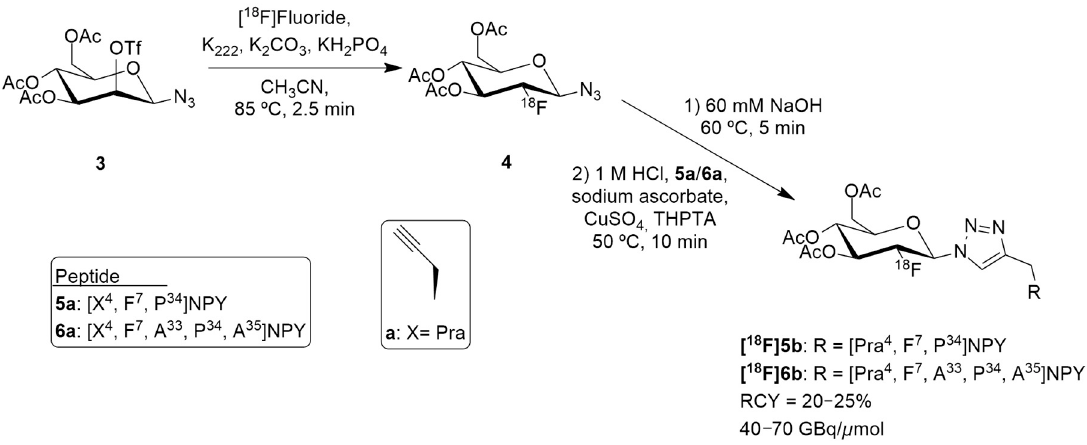
Figure 3. Radiosynthesis of [ 18 F]5b and [ 18 F]6b .